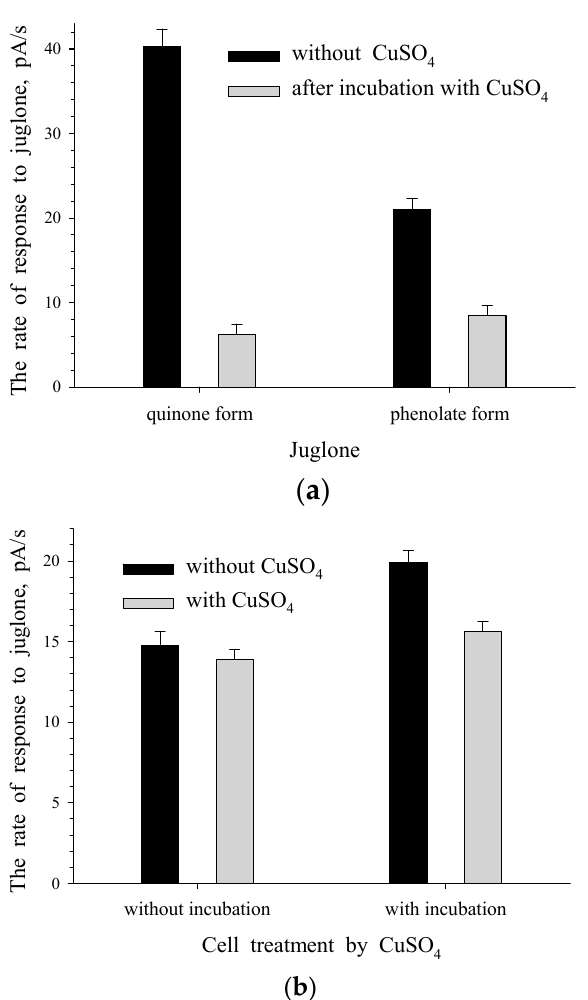
Figure 4. Responses to juglone for intact ( a ) and immobilized ( b ) cells of Rhodococcus sp. 3 in the presence and absence of CuSO 4 (without incubation) and after incubation in the presence and absence of CuSO 4 (with incubation).